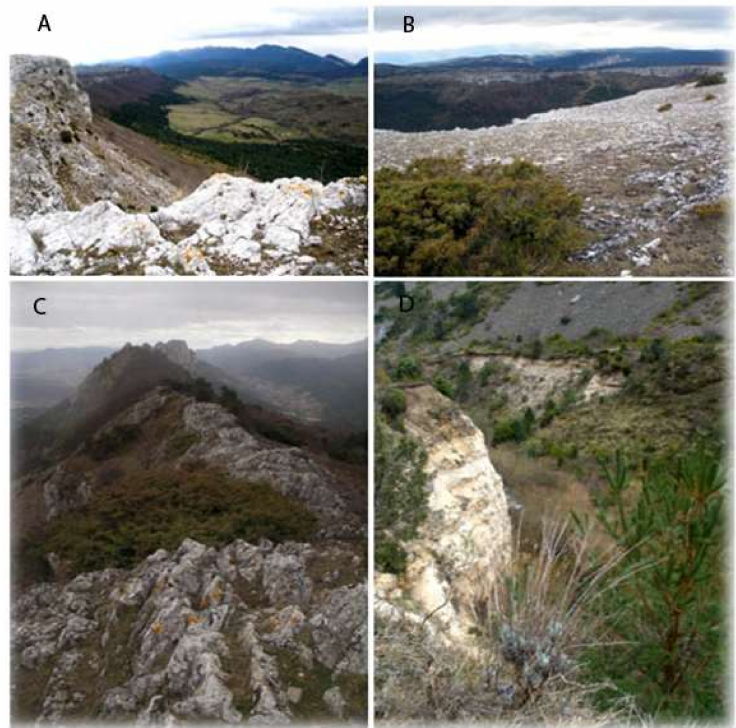
Figure 2. Panoramic views of the Valderejo Natural Park. ( A ) Panoramic view from Ler ó n Peak; ( B ) Panoramic view from El Recuenco; ( C ) Arrayuelas; ( D ) Pur ó n River.